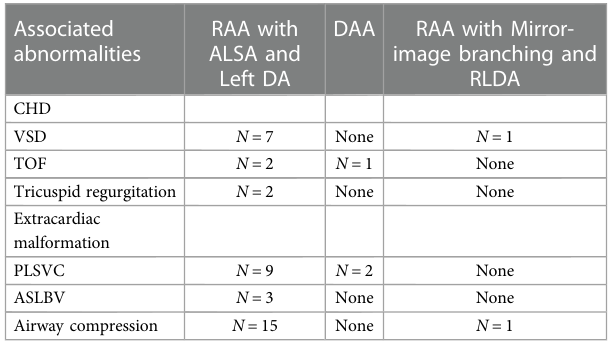
Three cases of RAA with ALSA and Left DA with duplicate counts, due to one suffering both tricuspid regurgitation and PLSVC simultaneously and two suffering both VSD and PLSVC simultaneously. CHD, congenital heart disease; VSD, ventricular septal defect; TOF, tetralogy of Fallot; PLSVC, persistent left superior vena cava; ASLBV, abnormal subaortic left brachiocephalic vein; RAA with ALSA and left DA, right aortic arch with aberrant left subclavian artery and left ductus arteriosus; DAA, double aortic arch; RAA with mirror-image branching and RLDA, RAA with mirror-image branching and retroesophageal left ductus